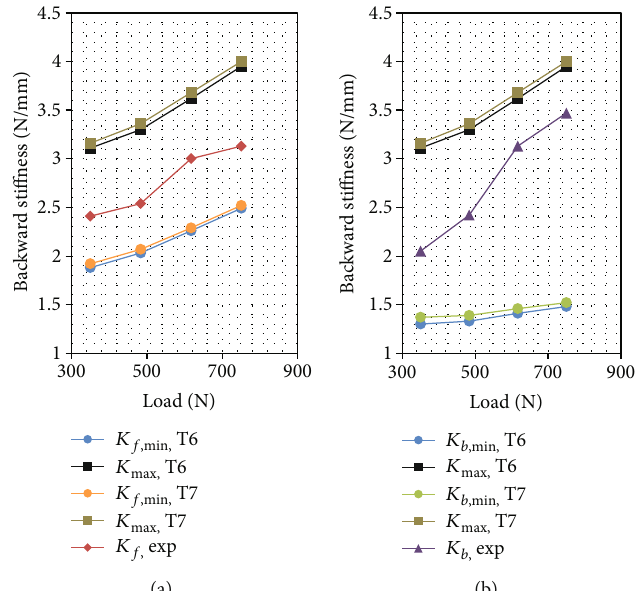
Figure 4: Bracketing of (a) forward and (b) backward trunk sti ff ness with respect to the load for tonus levels T6 (15%, 24%, and 36%) and T7 (15%, 32%, and 36%) for classes C1, C2, and C3,